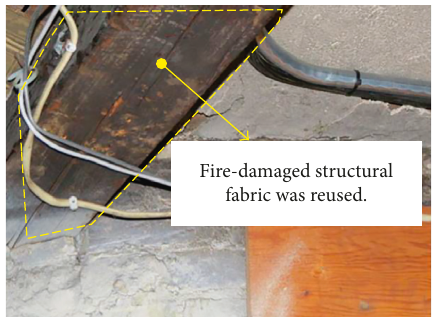
Figure 2: Charred heavy timber beam surviving from 1902 fire in Guardian Angels Church and reused in the rebuild